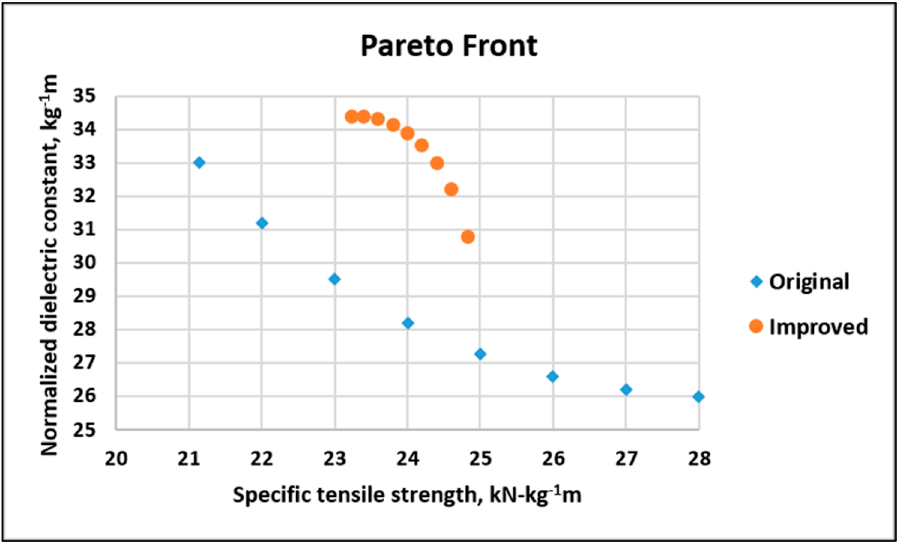
Figure 26. Dielectric versus tensile for the original and improved systems.